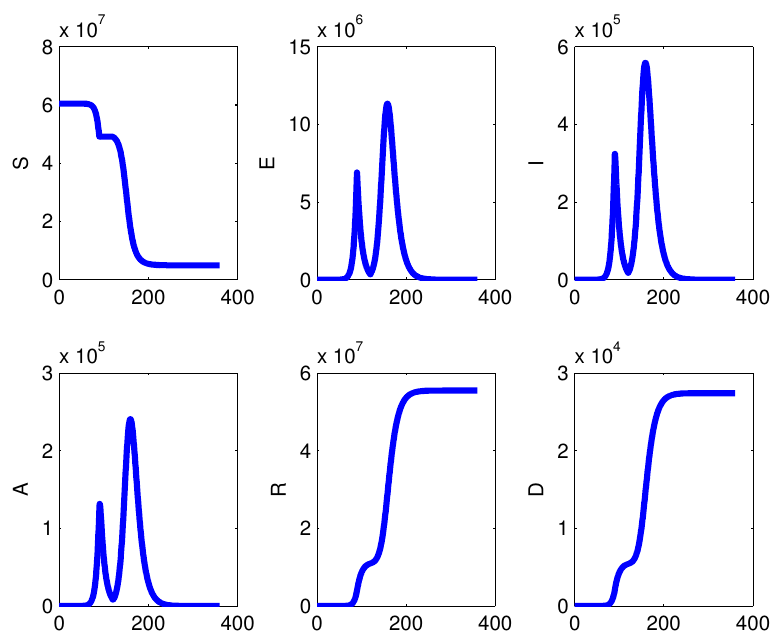
Figure 12. The total populations with the lock-down policy, implemented from time 90 up to time 120, with the total isolation policy β I = 0, after which β I = 10 − 7 resumes. The simulation runs over a one year timespan for the simplified model (1) with no demographics, Λ = d p = 0. Left to right and top to bottom, the subpopulations are: S , E , I , A , R and D , the disease-related deceased class.